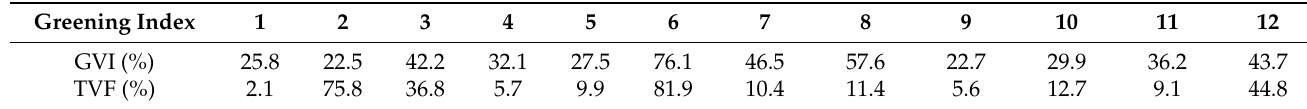
Figure 3. The extraction process from images to greening indices. Table 1. Values of the GVI and TVF at each sampling point.